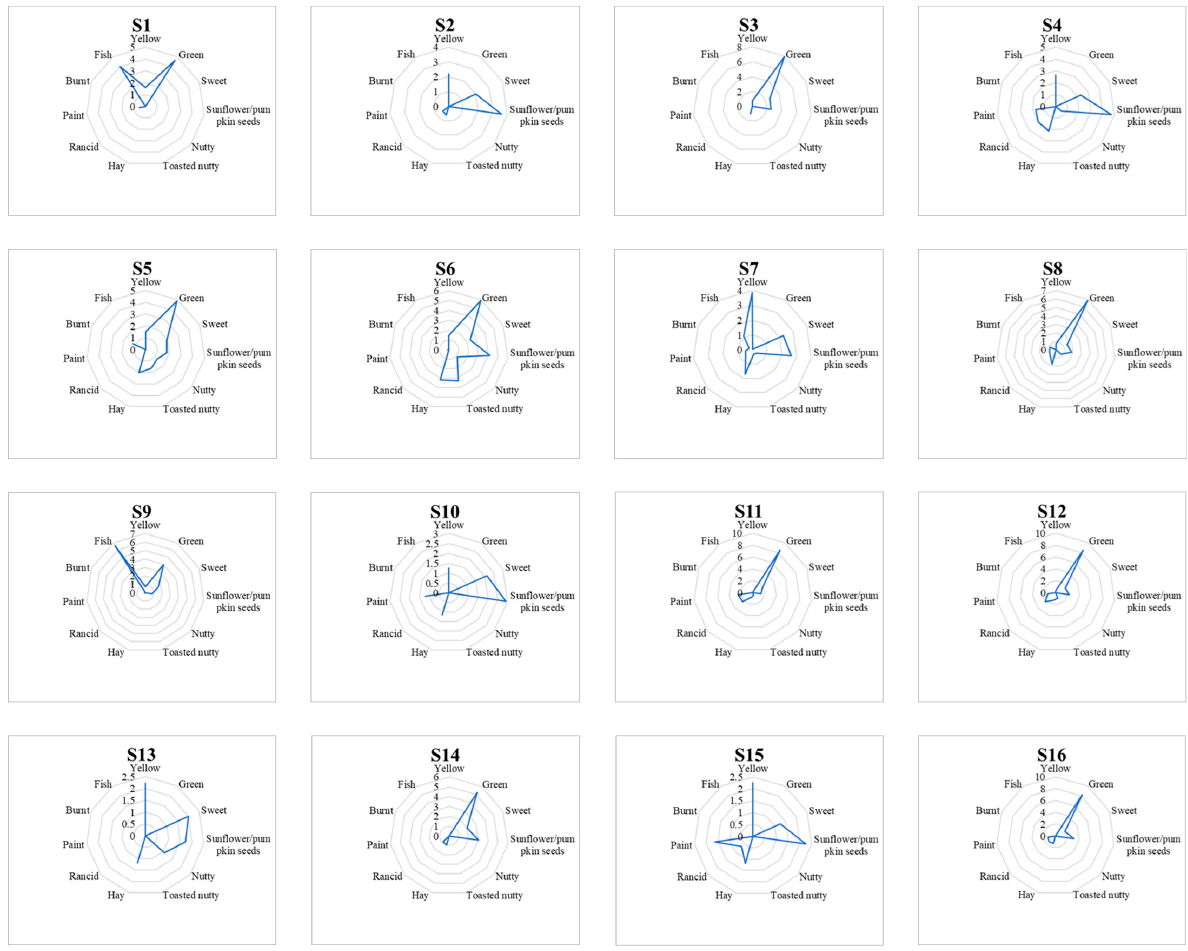
Figure 4. Spider graphs representing the sensory profiles of the 16 CP-HSOs (named from S1 to S16) analyzed.